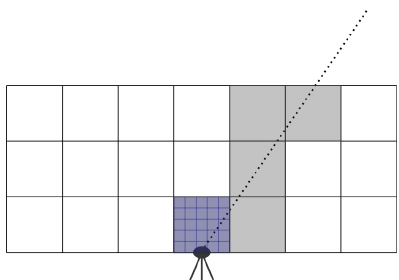
Figure 1. Schematic illustration of the generation of synthetic GNSS SWDs according to Heublein (2019): within each tomo- graphic voxel (grey), the WRF refractivities of all those WRF cells (blue) situated within that voxel are averaged. A direct ray tracing along the considered signal direction then yields the SWD intro- duced into the tomographic system.